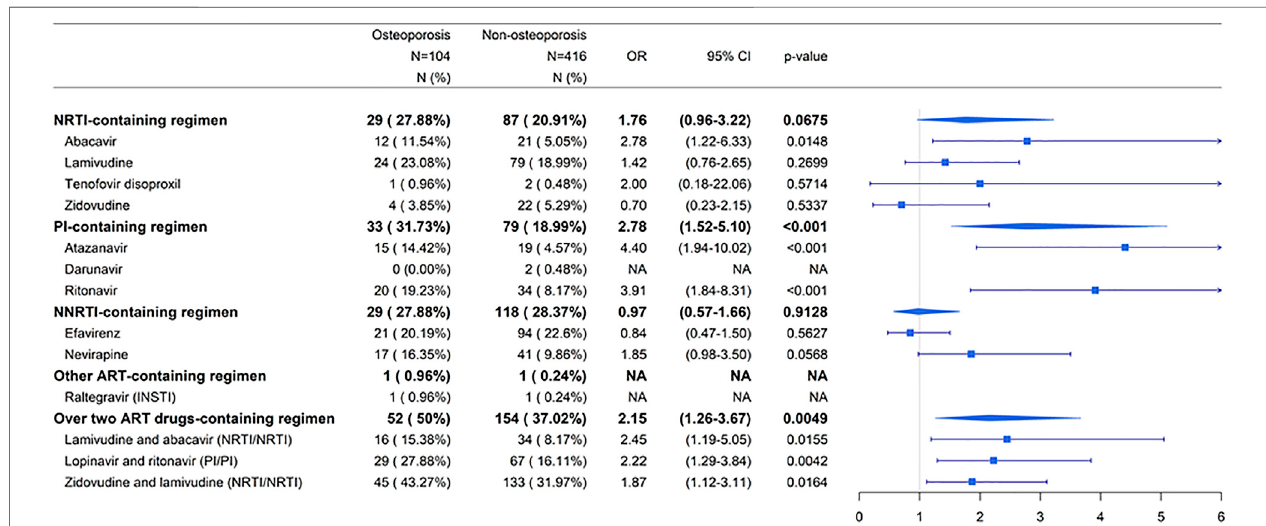
FIGURE 2 | Summarized associations between individual ART drugs and risk of osteoporosis compared to non-ART use. Abbreviations: ART, antiretroviral therapy;NRTI,nucleoside/nucleotidereversetranscriptaseinhibitor;PI,proteaseinhibitor;NNRTI,non-nucleosidereversetranscriptaseinhibitor;INSTI,integrasestrand transfer inhibitor; N, number; OR, odds ratio; CI, con fi dence interval; NA, not applicable.